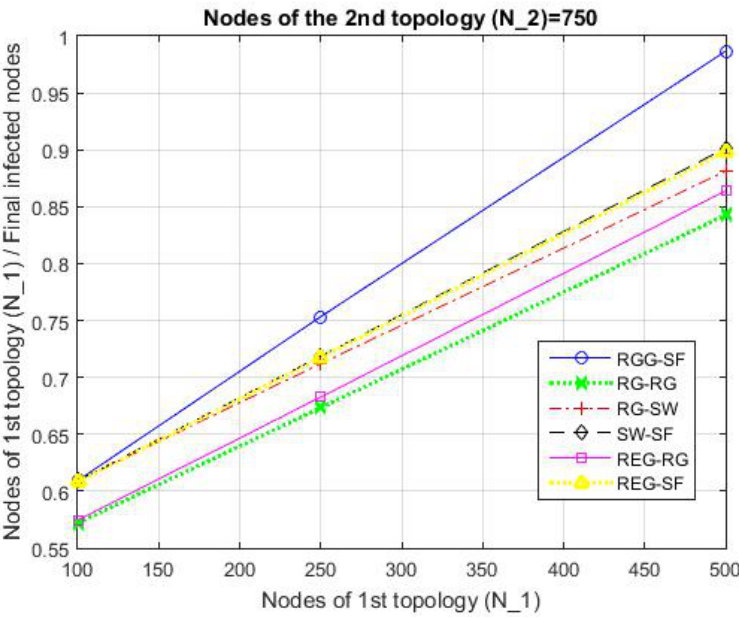
Figure 14. Spread of malware while the nodes of the 2nd topology remain equal to N_1 =